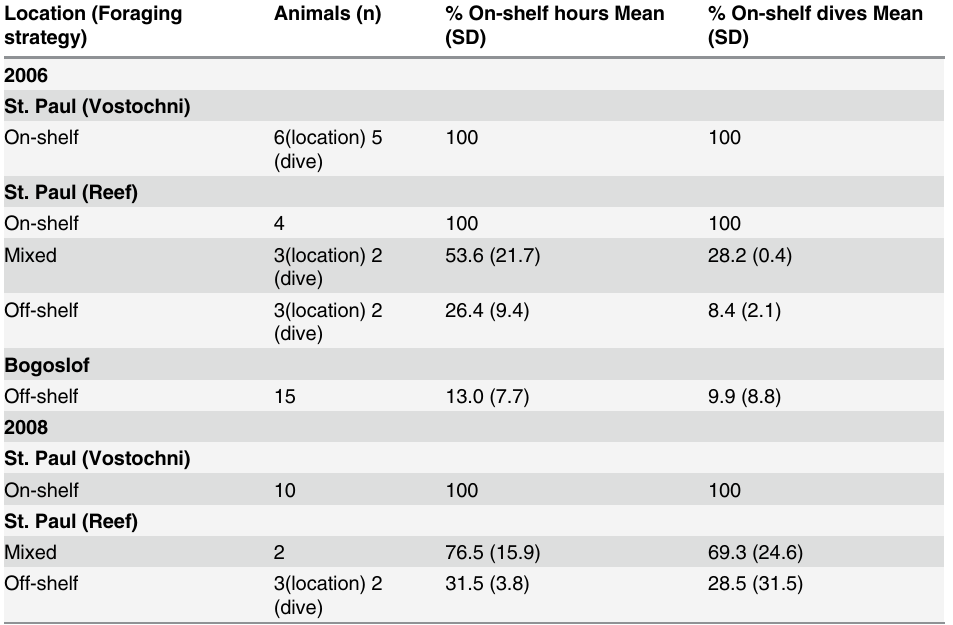
Sample sizes include number of animals with location and dive